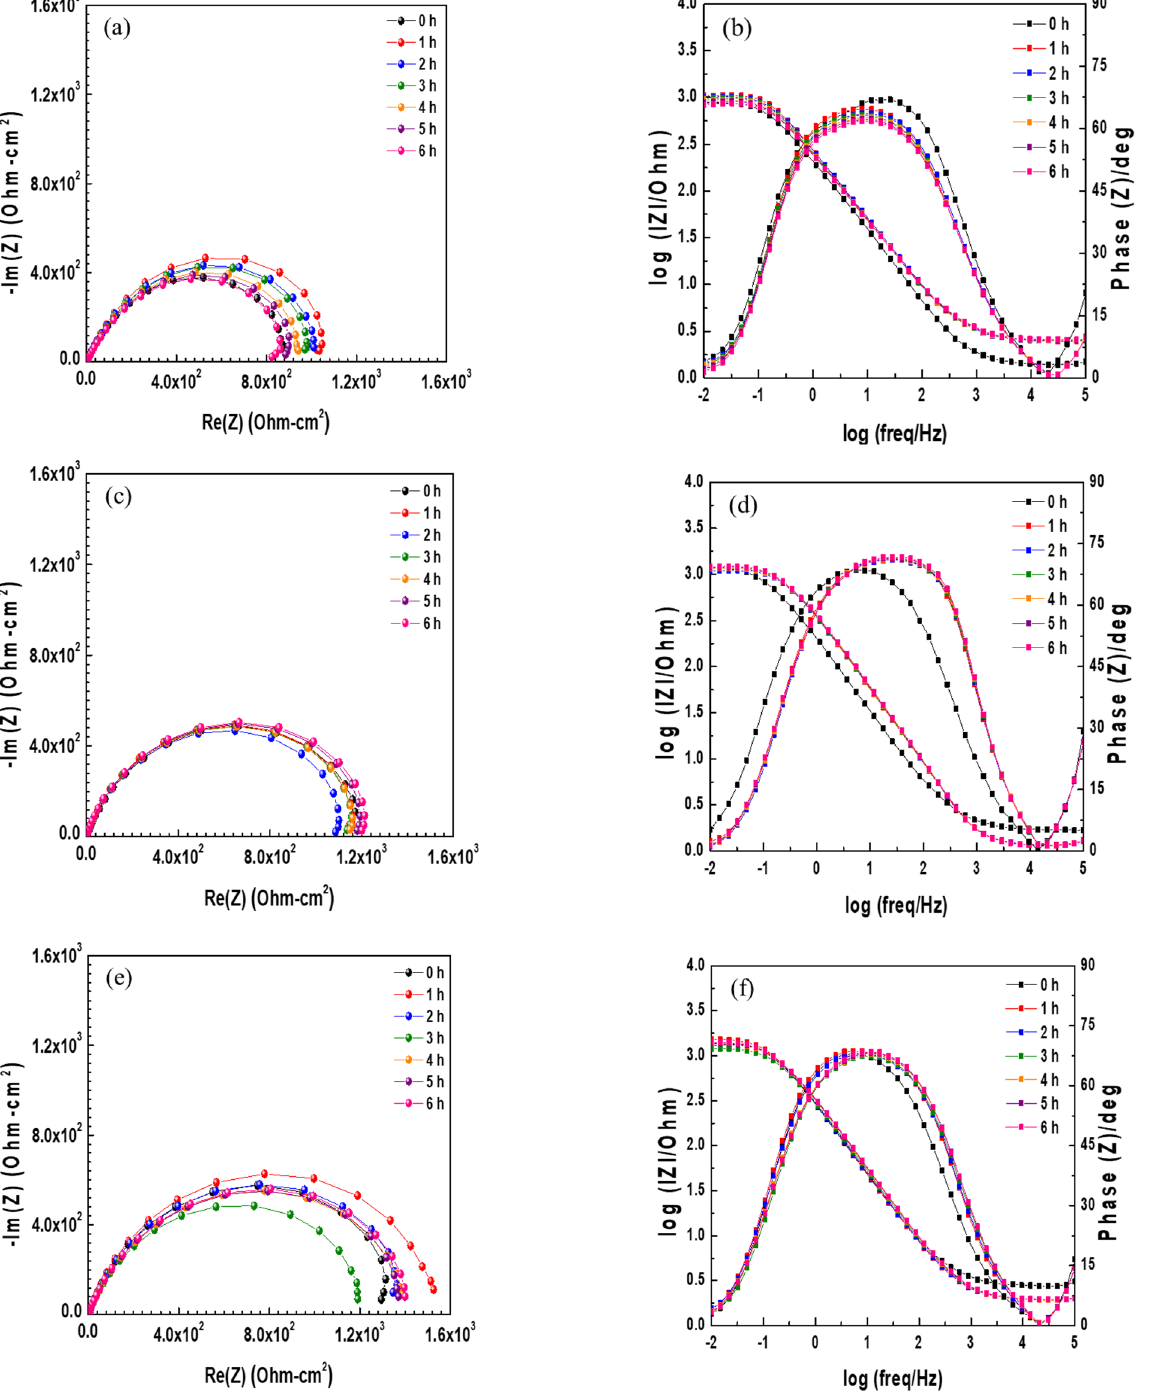
Figure 4. Nyquist and Bode impedance plots of EIS data of ( a , b ) 0 Cr steel, ( c , d ) 0.3 Cr steel, and ( e , f ) 0.5 Cr steel in 3.5 wt.% NaCl solution.